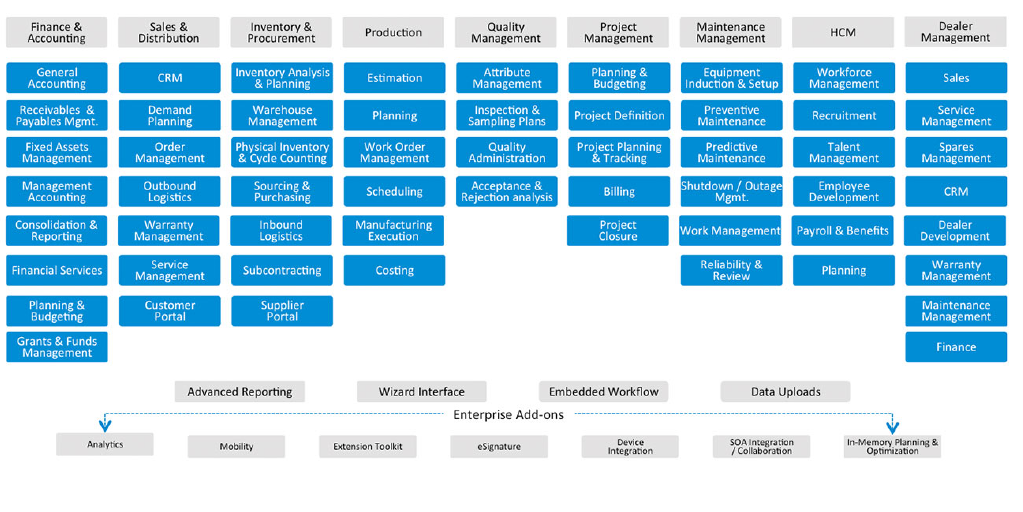
Fig. 1. Enterprise Resource Planning